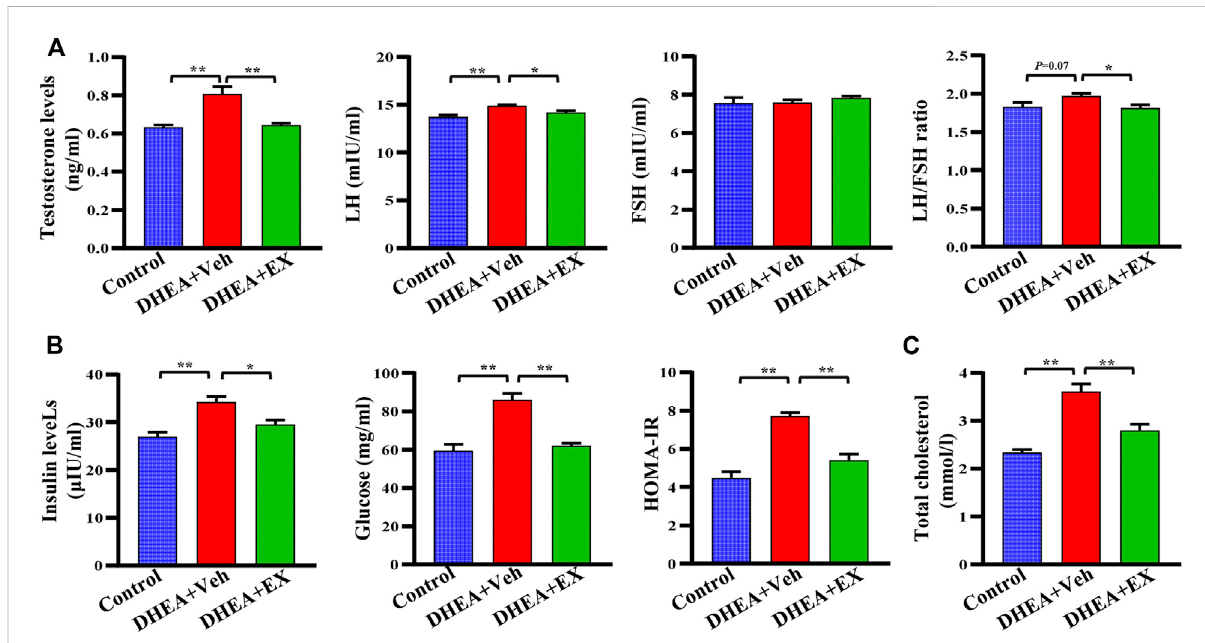
FIGURE 2 Enoxacin treatment improved hormone disorders in DHEA-treated mice upon chow diet. (A) The levels of reproductive hormones including testosterone,theLH,FSHandLH/FSHratio. (B) Thelevelsofinsulin,fastingserumglucose,andHOMA-IRscore. (C) Levelsofserumtotalcholesterol. Values are represented as the mean ± SE. n = 5 – 6. P values were determined by one-way ANOVA with Tukey ’ s multiple comparison post-hoc test. * p < 0.05, ** p < 0.01. DHEA, dehydroepiandrosterone; Veh, vehicle; EX,